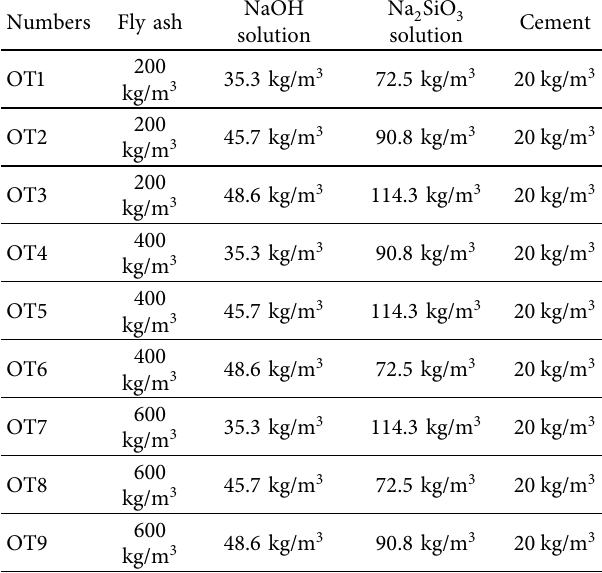
Table 2. The test methods refer to the GB/T 50082-2009 Standard for test methods of long-term performance and durability of ordinary concrete [28] to carry out the effect of salt solution on the strength behaviours of geopolymer concrete under dry-wet cycles.